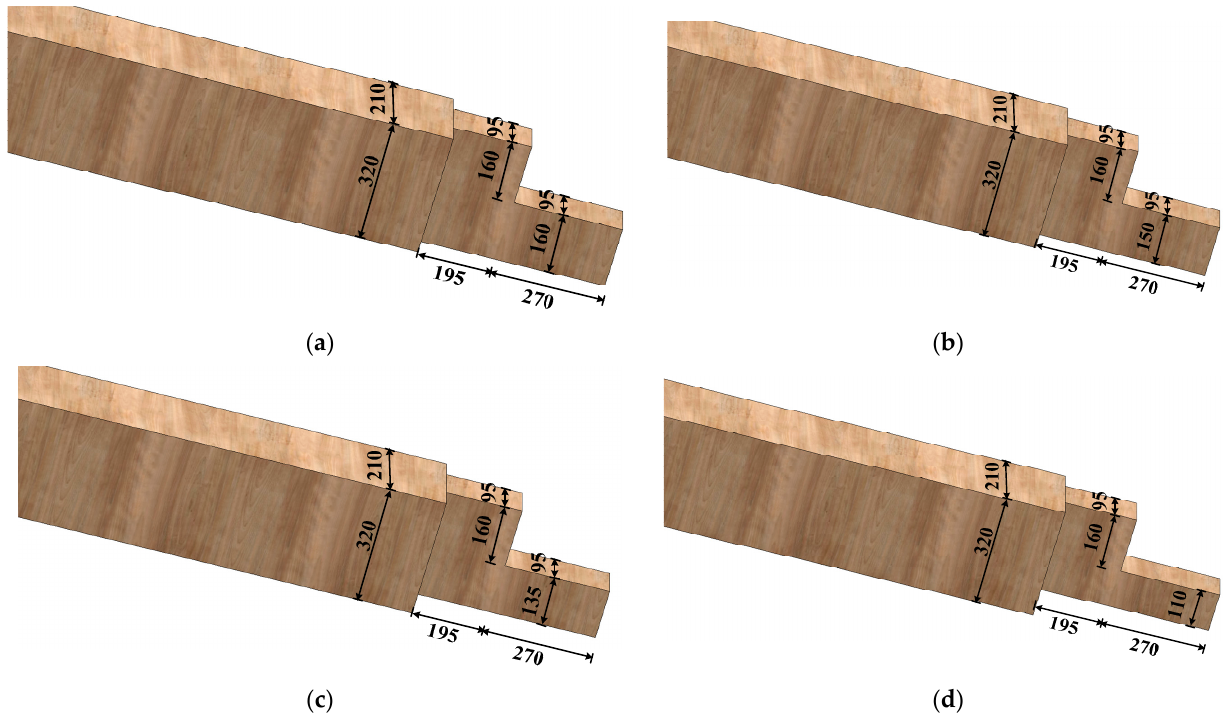
Figure 14. Detail dimension of fang. ( a ) Loose joint-1. ( b ) Loose joint-2. ( c ) Loose joint-3. ( d ) Loose